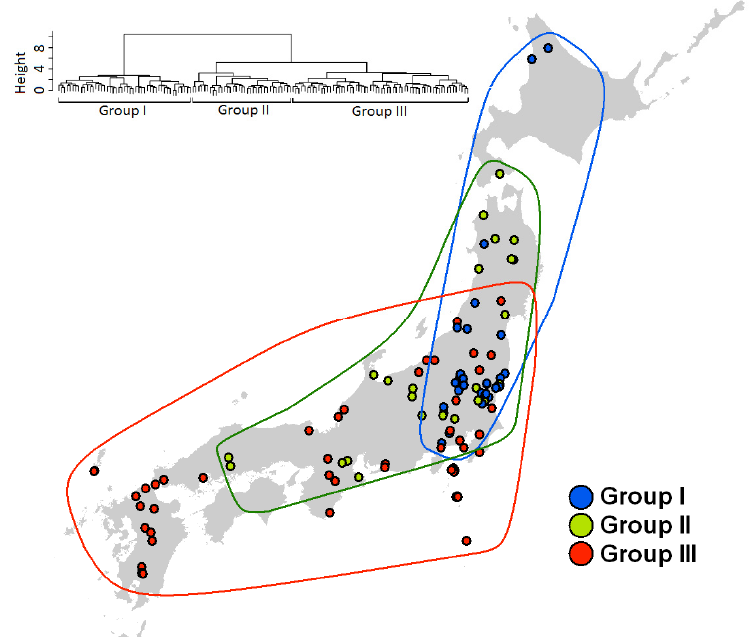
Figure 4. Cluster analysis and distribution of three Protura species assembly groups in which more than six species were recorded. IndVal analysis selected 7 to 9 indicator species from the three groups (Appendix: Table A2).